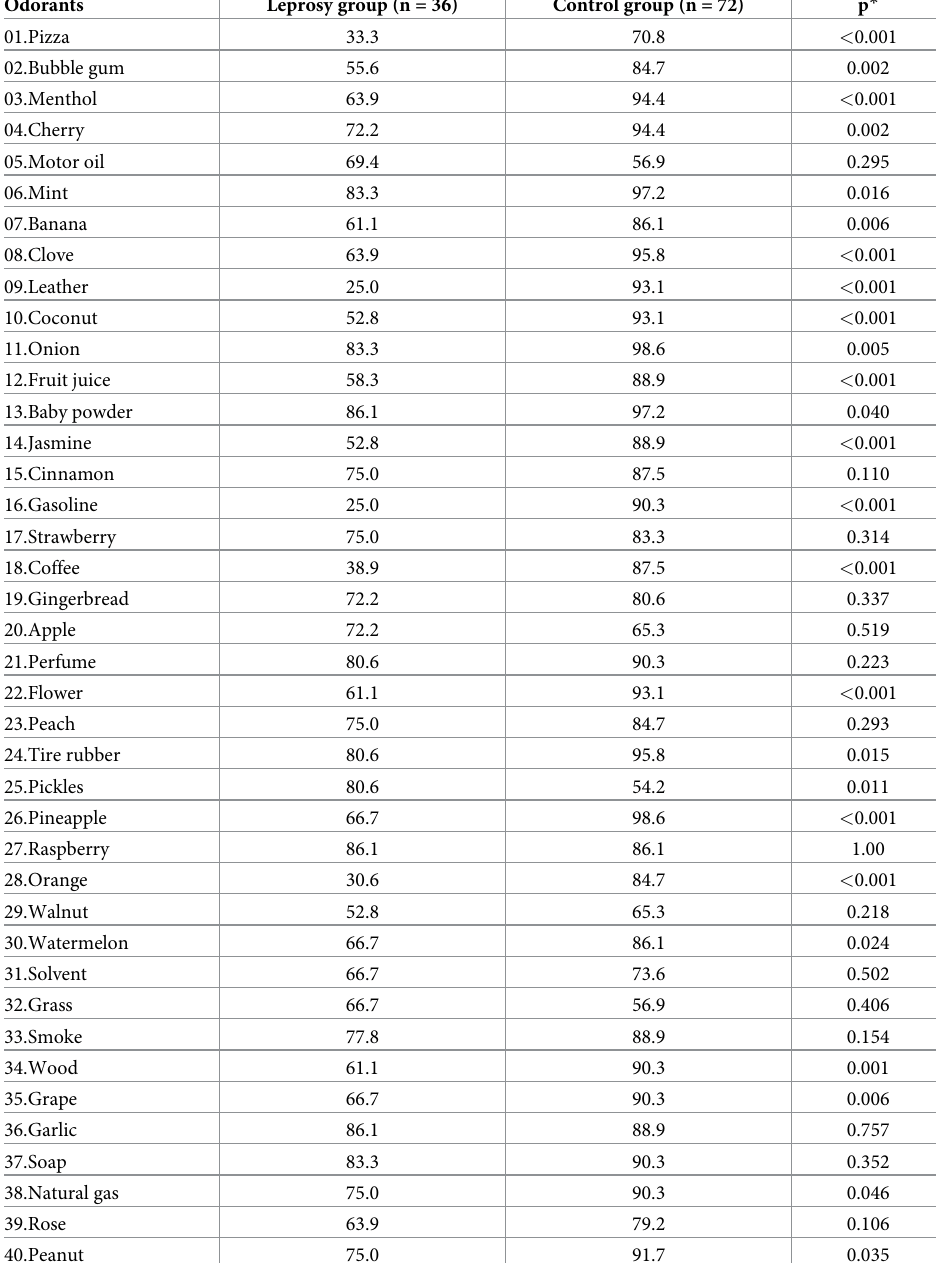
Table 4. Percentage of correct answers for each odorant among exposed individuals and control patients (N = 108). Odorants Leprosy group (n = 36) Control group (n = 72) p * 01.Pizza 33.3 70.8 < 0.001 02.Bubble